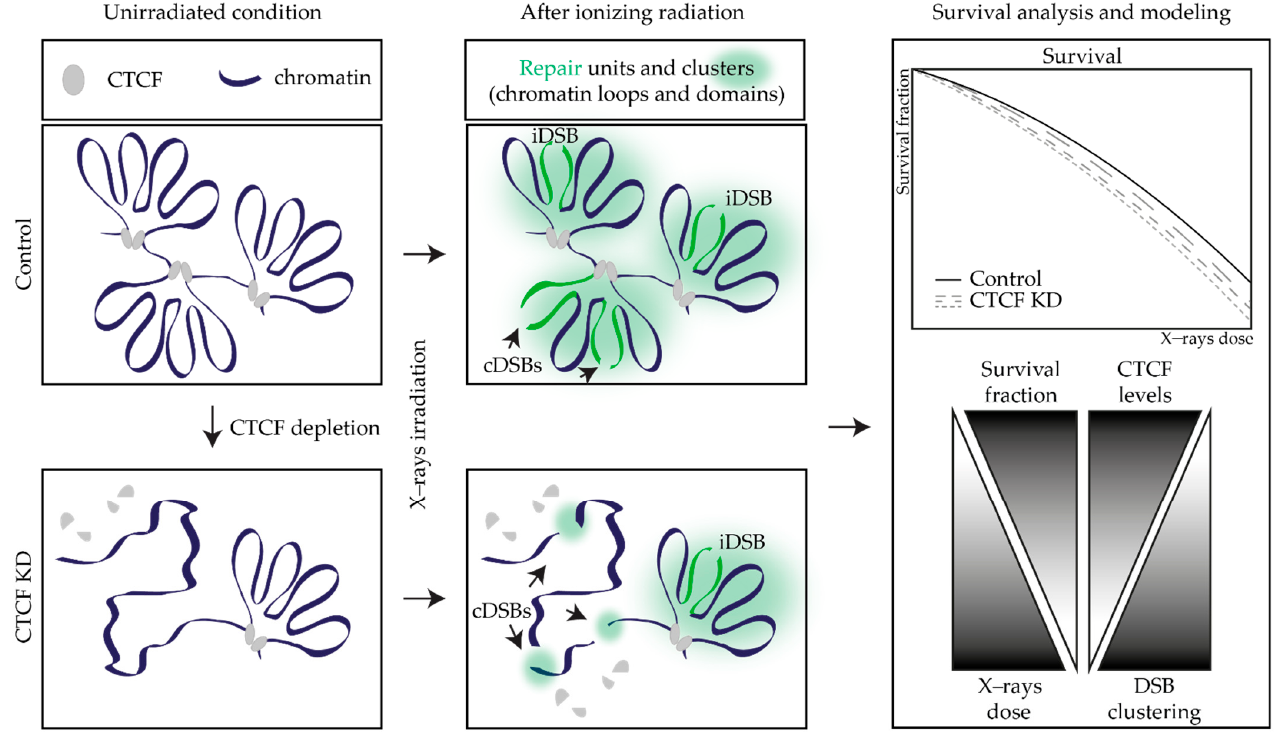
Figure 11. Lower CTCF levels lead to less chromatin domains and a higher probability that DSBs will not be separated into different chromatin domains (cDSBs). The cDSBs have higher lethality due to the loss of DNA, resulting in decreased survival.